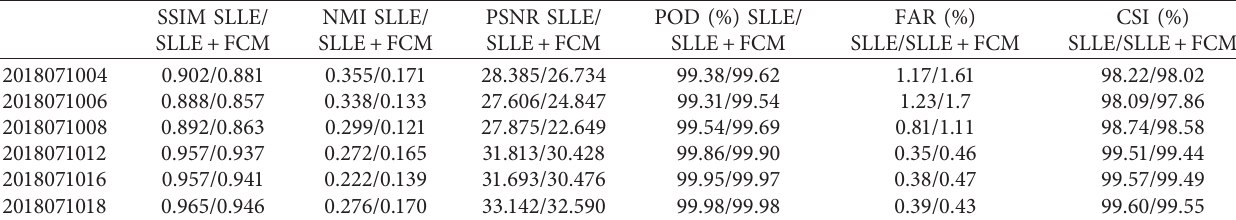
Table 1. This may be related to the inherent characteristics of the FCM method, which we will study in greater detail in the future.